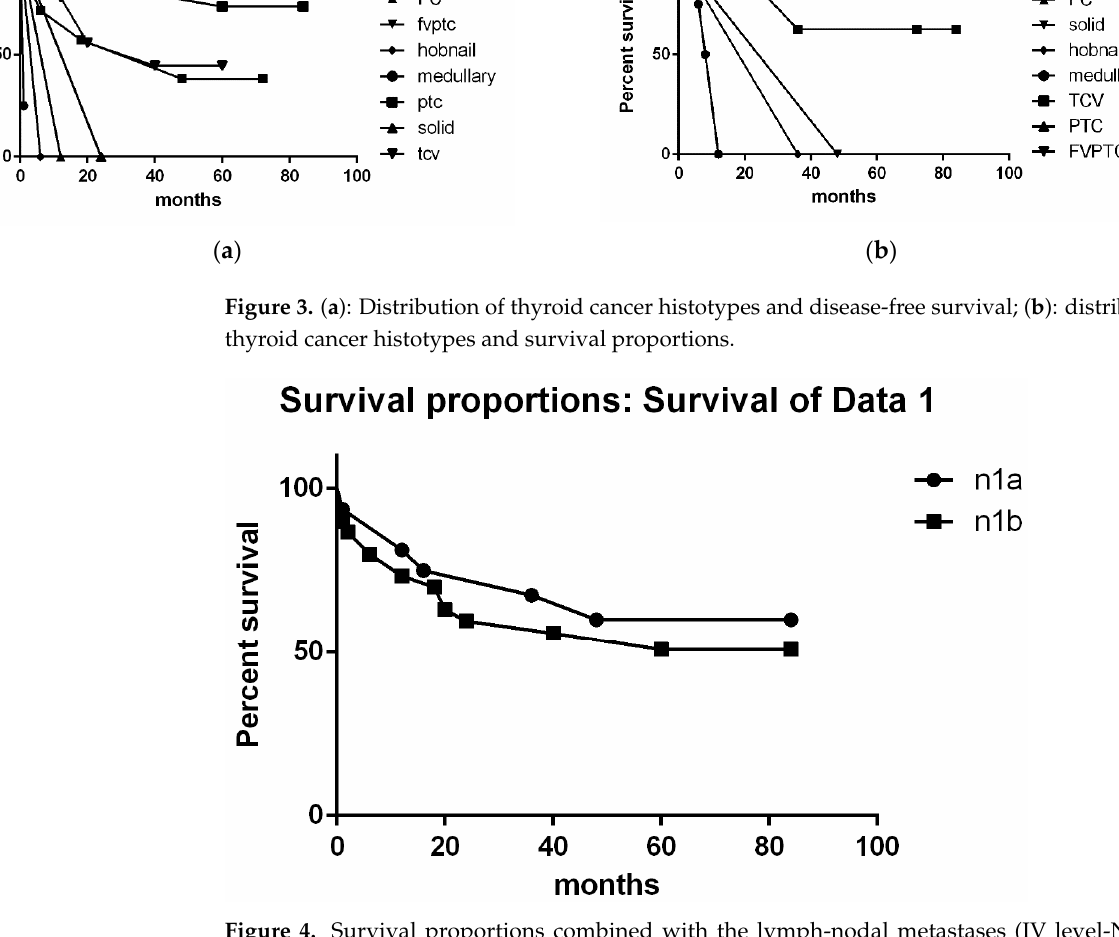
Figure 4. Survival proportions combined with the lymph-nodal metastases (IV level-N1a) and laterocervical (N1b).